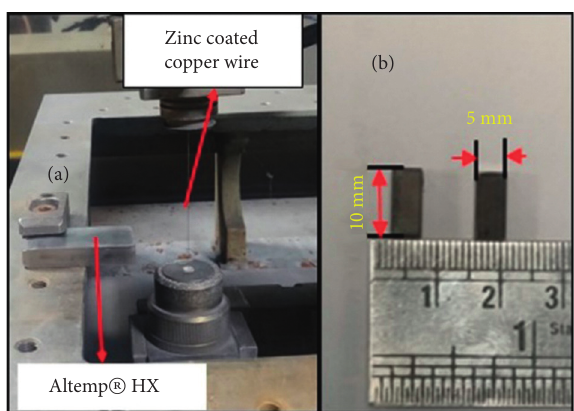
Figure 2: (a) Altemp HX fixed in WEDM table. (b) Workpieces machined at different parameters. Table 1: Machining parameters.